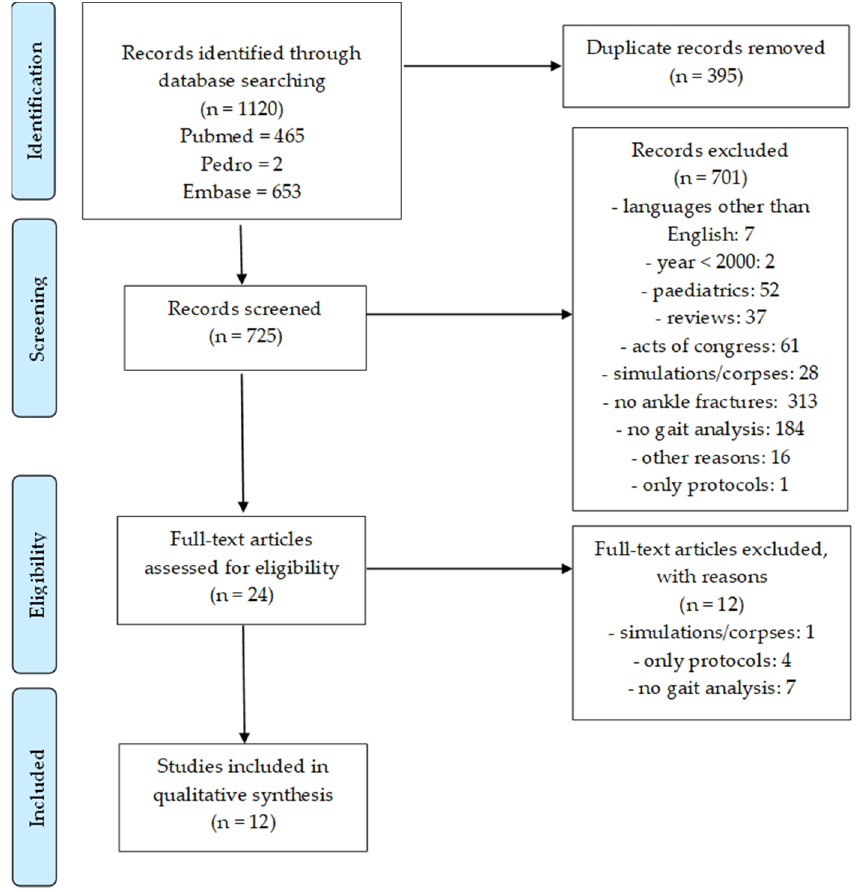
Figure 2. PRISMA flow diagram representing the search strategy and the selection of articles. Table 2. Methodological quality using the PEDro scale for randomized controlled trials. Items of the